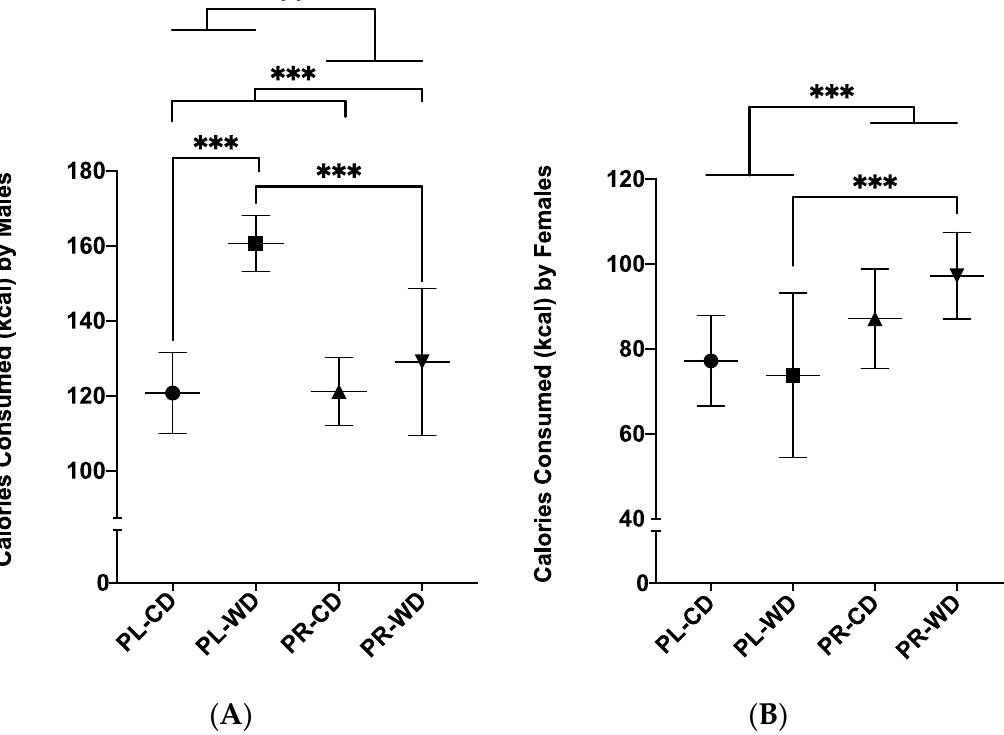
Figure 5. Food intake as measured by average calories consumed (kcal) over 4 days in placebo and probiotic rats given control diet or Western diet separated by ( A ) males and ( B ) females. Data expressed as M ( SD ). ** p < 0.01, *** p < 0.001. PL: placebo; PR: probiotic; WD: Western diet; CD: control diet.